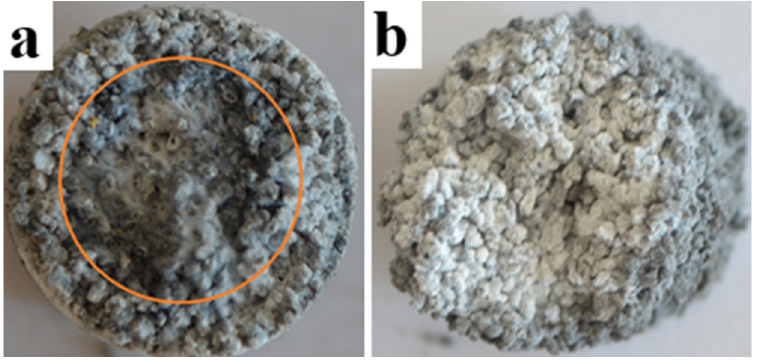
Figure 2. Appearance of the combustion products: ( a ) 50% AlN + 50% Al; ( b ) 70% AlN + 30% Al.